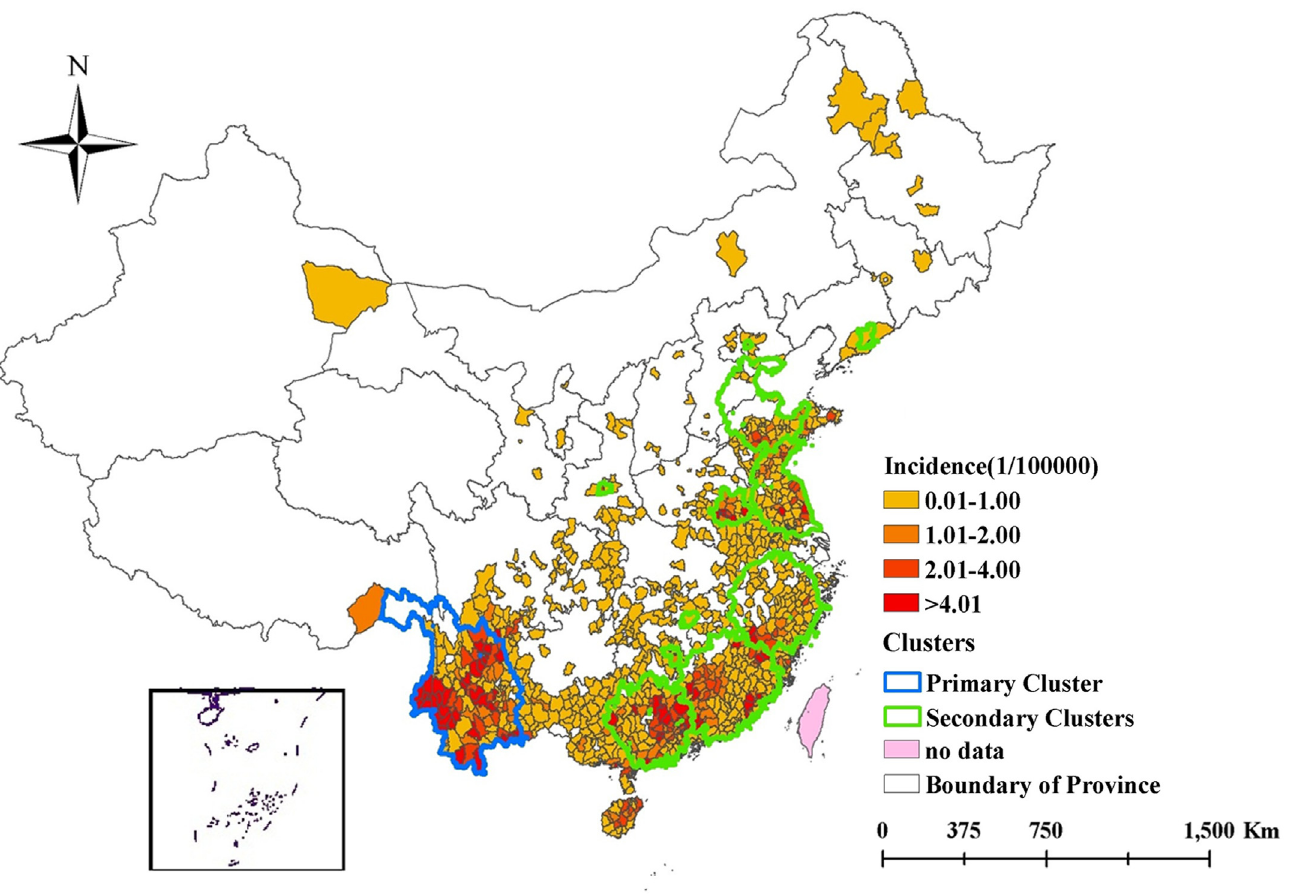
Fig 5. Spatiotemporal clusters overlay with annual average incidence of scrub typhus across the period of 2006 – 2014 in mainland China.